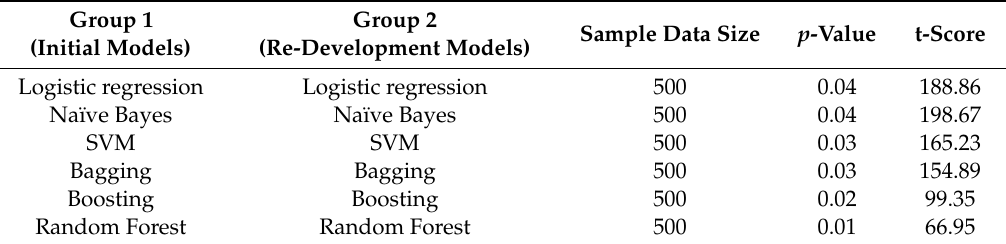
Table 7. Performance of models in re-development phase after privacy preservation.